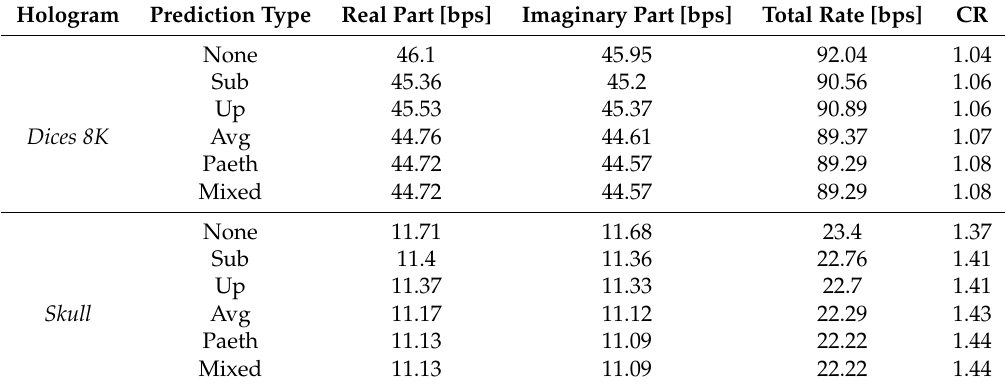
Table 2. PNG compression results.